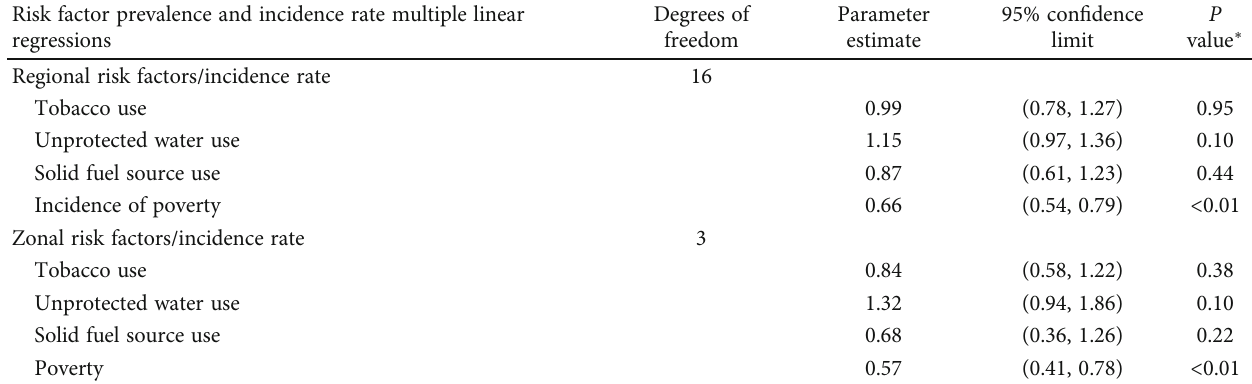
Table 6: Poisson regressions for the association between prevalence of etiologic risk factors for esophageal cancer and incidence rate. Risk factor prevalence and incidence rate multiple